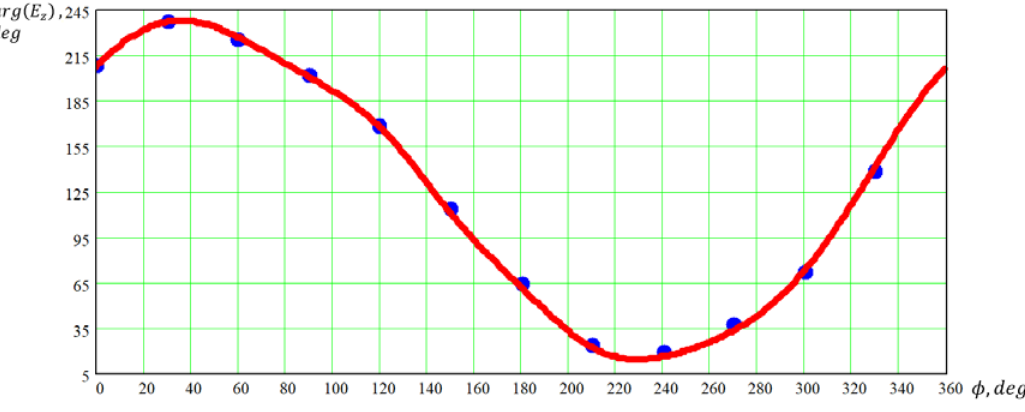
Figure 5. Phase distributions of 𝐸 (cid:3053) ‐ field on a circle with radius 𝑟 (cid:3404) 1 m (antenna array radius 𝑅 (cid:3404) 0.5 m) obtained by numerical simulation (circles) and approximation (solid lines) at frequency 𝑓 (cid:3404) 140 MHz.